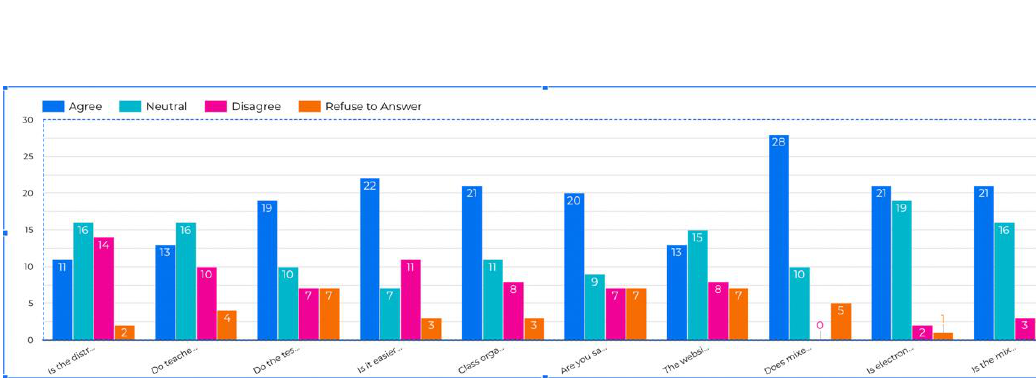
Figure 2. Experimental results for students’